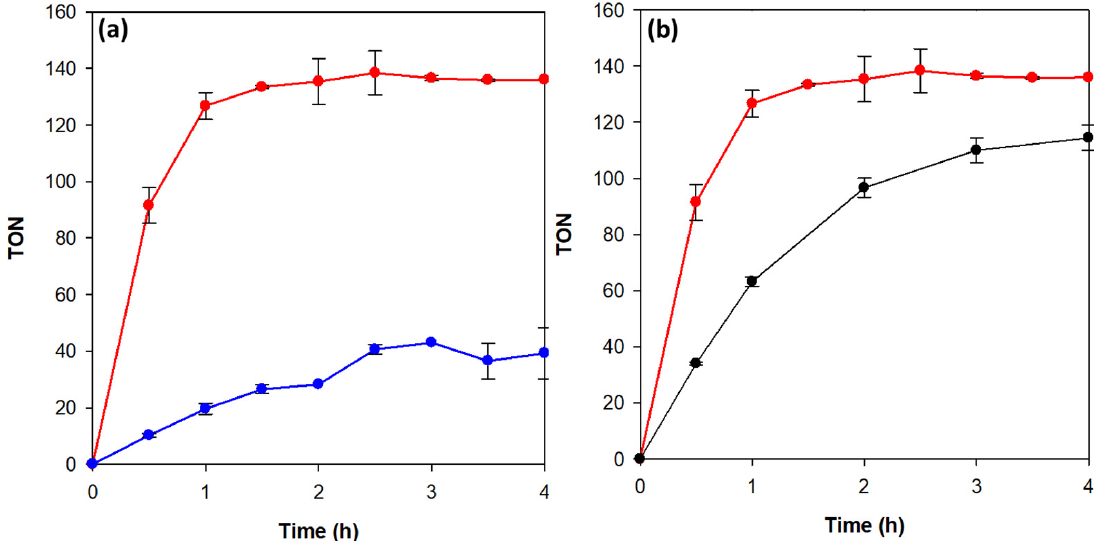
Figure 7. ( a ) Photocatalytic HER with Im-EtPMO-Co (red line) and Co(dmgH) 2 (Im)Cl homogeneous catalyst (blue line). ( b ) Photocatalytic HER with Im-EtPMO-Co (red line) and py-etPMO-Co (black line) as catalysts.